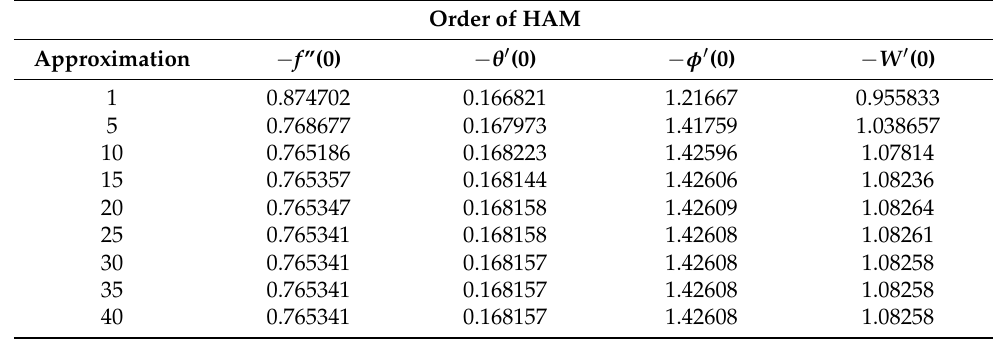
Figure 4. ( a – f ). The impact of the numerous variables of θ ( η ) : ( a ) λ 1 , ( b ) Rd , ( c ) Nt , ( d ) Nb , ( e ) Bi and ( f ) Pr . Table 1. Convergence solution of HAM. Order of